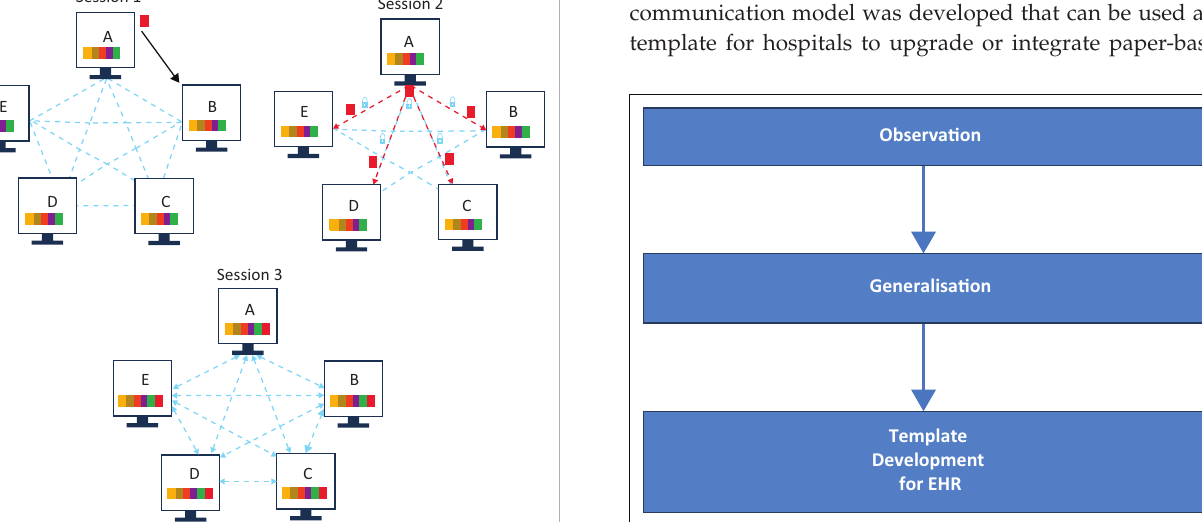
FIGURE 3: The use of distributed information technology blockchain in electronic health record.